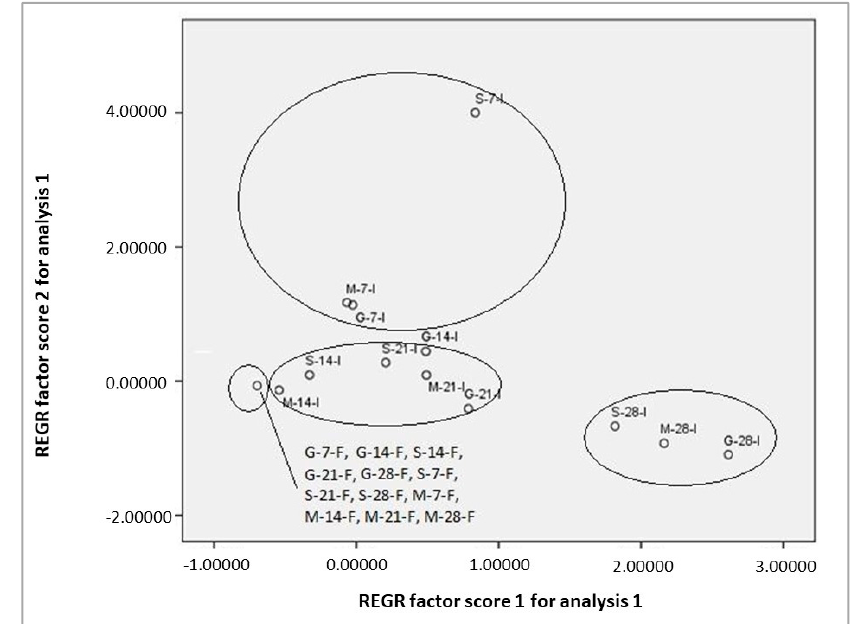
Figure 2. Principal component analysis (PCA) plot of terpenoids in fermentation batches of synthetic mediums by free or immobilized S. cerevisiae AXAZ-1 cells on Pistacia terebinthus resin at different temperatures. (The numbers in the sample codes indicate the fermentation temperature. G: glucose synthetic medium, S: Sucrose synthetic medium, M: maltose synthetic medium. I: Immobilized Saccharomyces cerevisiae AXAZ-1 cells on Pistacia terebinthus resin, F: Free cells of Saccharomyces cerevisiae AXAZ-1).